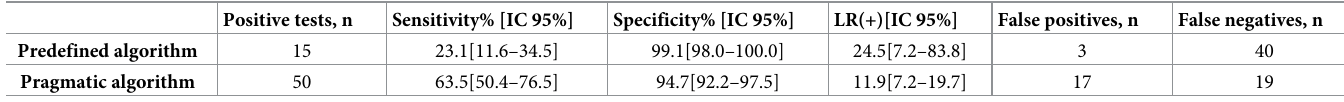
Table 3. Validity of HDD to detect complicated ectopic pregnancies with severe bleeding (CEPSB) in two gynecological units in 2012 (N = 370).